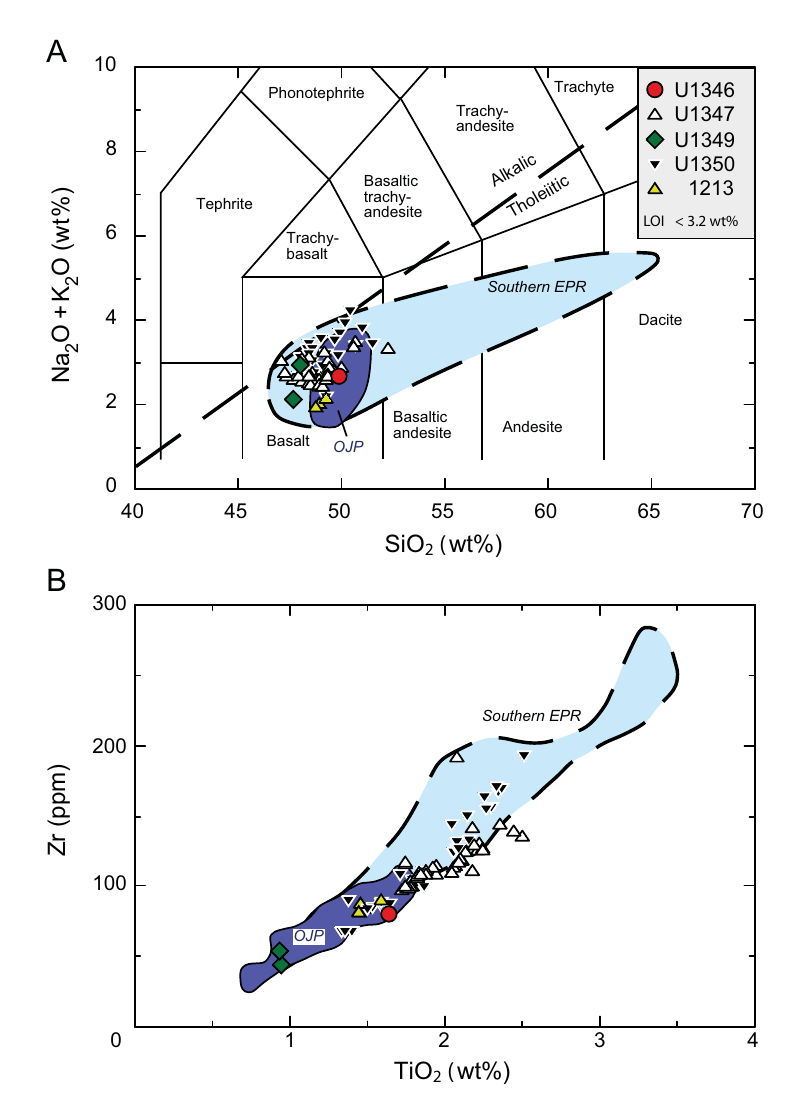
TiO wt 2 ( Figure 4. Chemical characteristics of Shatsky Rise basalt samples. [A] Total alkalis vs. silica for least-altered samples with rock classification of Le Maitre et al. (1989). Dashed line divides Hawaiian tholeiitic and alkalic lavas. All data are normalized to 100 wt% totals. [B] TiO 2 vs. Zr. Site 1213 data are from Mahoney et al. (2005). OJP = Ontong Java Plateau (data of Tejada et al., 1996, 2002; Fitton and Godard, 2004), EPR = East Pacific Rise (data of Sinton et al., 1991; Bach et al., 1994; Mahoney et al., 1994).